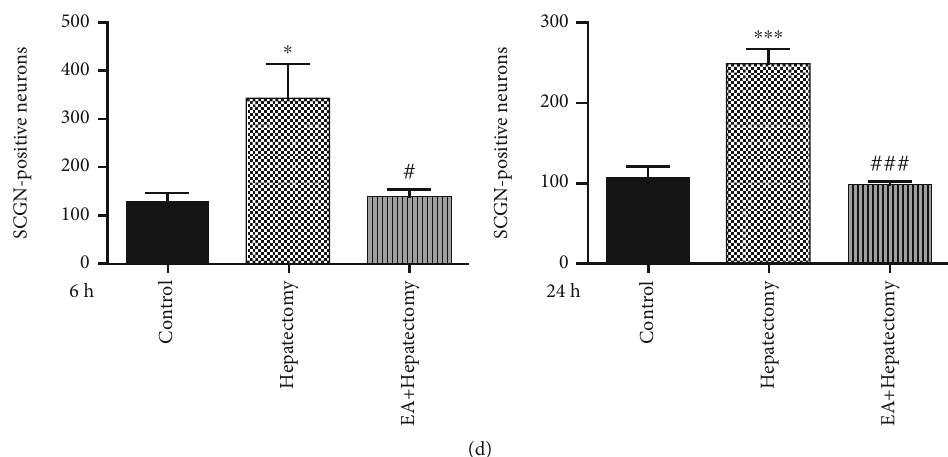
Figure 2: SCGN expression in the PVN of rats. (a) Representative bands of SCGN protein levels and quanti fi cation of SCGN protein levels and (b) SCGN mRNA levels at 6 h and 24 h in the control, hepatectomy, and EA+hepatectomy groups after hepatectomy. (c) Immuno fl uorescence staining of SCGN in the PVN among the control, hepatectomy, and EA+hepatectomy groups at 6h and 24 h after surgery. Scale bar = 100 μ m . (d) Quanti fi cation of SCGN-positive neurons in the control, hepatectomy, and EA+hepatectomy groups at 6 h and 24h after hepatectomy. Data are presented as the mean ± SEM ( n = 4 ). ∗ vs. control group ( p < 0 : 05 ): ∗∗ p < 0 : 01 , ∗∗∗ p < 0 : 001 ; # vs. hepatectomy group ( p < 0 : 05 ): ## p < 0 : 01 , ### p < 0 : 001